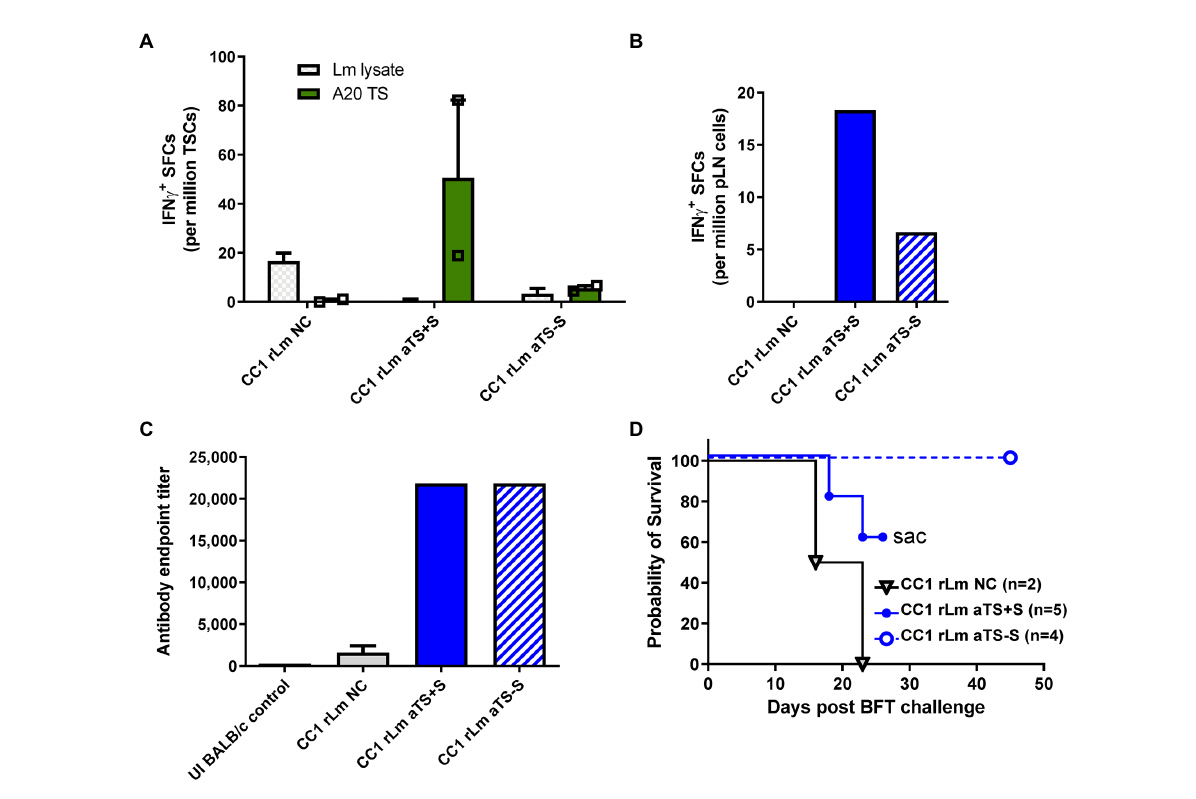
FIGURE 4 Recombinant TS-expressing CC1 L. major parasites induce T cell and antibody responses protective against T. cruzi challenge. Mice were inoculated with 10 6 CC1 L. major parasites transfected with a control vector (NC), active secreted TS (aTS+S), or active non-secreted TS (aTS − S). Stronger TS-specific IFN- γ responses were detected on ELISPOT assay among spleen cells (A) and lymph node cells (B) recovered from mice vaccinated with CC1 r Lm aTS+S compared to NC, and to a lesser extent from mice vaccinated with CC1 r Lm aTS − S. Mice inoculated with CC1 parasites expressing either form of active TS protein had significantly higher TS-specific antibody titers compared to control, when measured by ELISA assay (C) . Mice vaccinated with CC1 rLm aTS − S survived after a normally fatal challenge (D) . Mice vaccinated with CC1 rLm aTS+S also survived longer than control mice, but were euthanized due to the development of severe necrotizing lesions at the inoculation site (D)